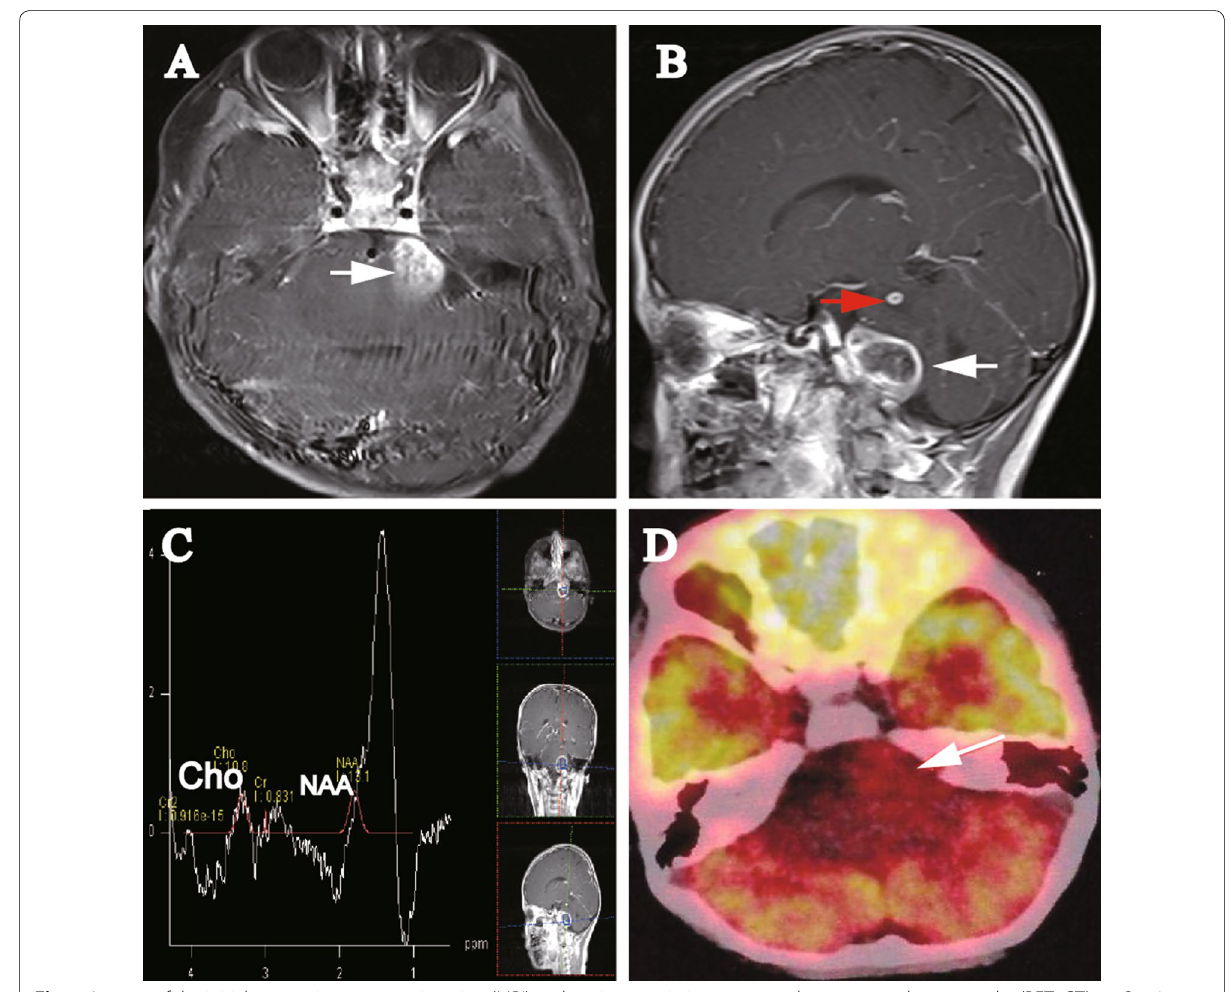
Fig. 1 Images of the initial magnetic resonance imaging (MRI) and positron emission tomography–computed tomography (PET–CT) on Oct 8, 2015 for the 5-year-old girl with multiple posterior fossa lesions. A Axial gadolinium-enhanced MRI displays a lesion (2.0 cm 2.6 cm; white arrow ) × in the cerebello-pontine angle (CPA). No relatively clear margin was observed between the lesion and the pons. B Sagittal gadolinium-enhanced MRI shows two lesions. The upper left pontine lesion (0.5 cm 0.6 cm) was significantly gadolinium-enhanced with relatively clear margin ( red × arrow ). From the sagittal view, the CPA lesion ( white arrow ) seemingly demonstrates clear boundary to the pons. C Magnetic resonance spectros- copy (MRS) of the lesion shows a decrease in choline (Cho) and N -acetyl aspartate (NAA). D PET–CT image demonstrates a hypometabolic lesion ( white arrow ) in the left side of the